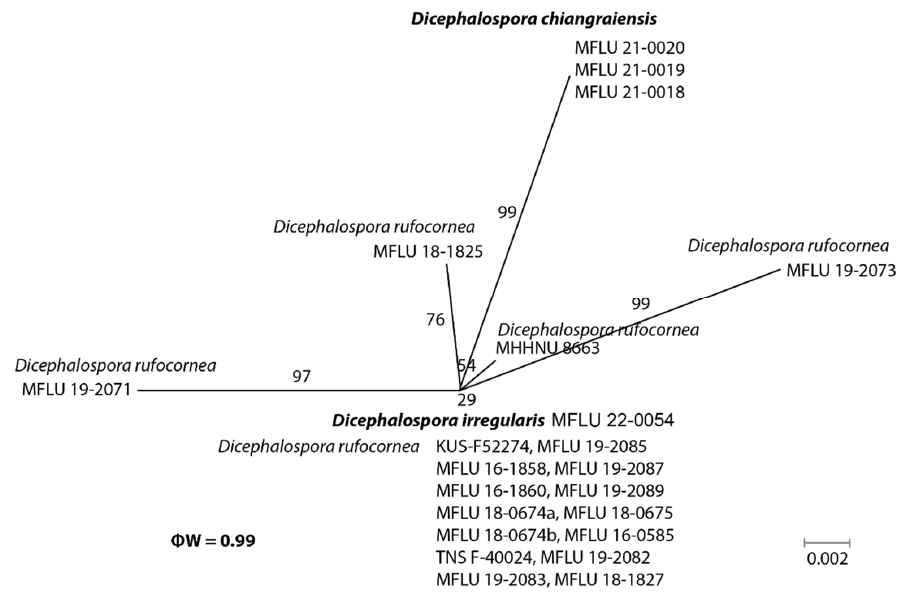
Figure 3. The results of the pairwise homoplasy index (PHI) test for the closely related species of Dicephalospora chiangraiensis using both LogDet transformation and splits decomposition. PHI test results ( ф w) < 0.05 indicate significant recombination within the dataset.